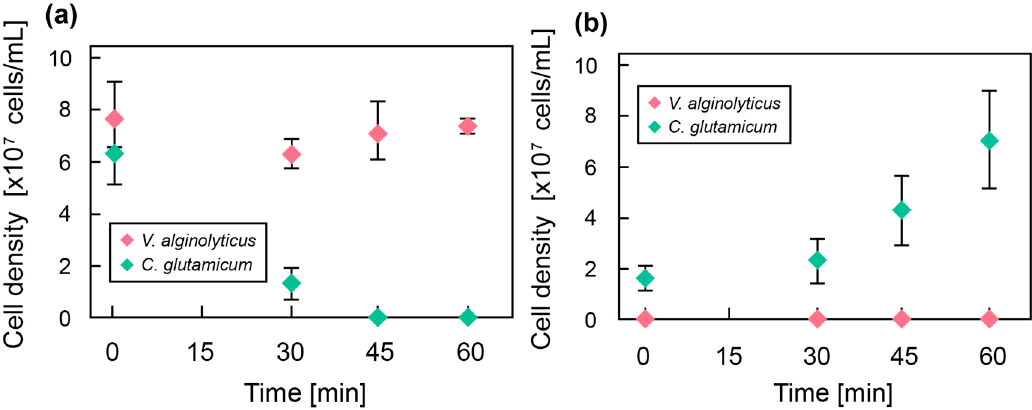
Figure 6. ( a ) Cell density of C. glutamicum and V. alginolyticus without the microfibers as a function of culture time. ( b ) Cell density of C. glutamicum in the microfiber exposed to a suspension containing V. alginolyticus as a function of culture time.